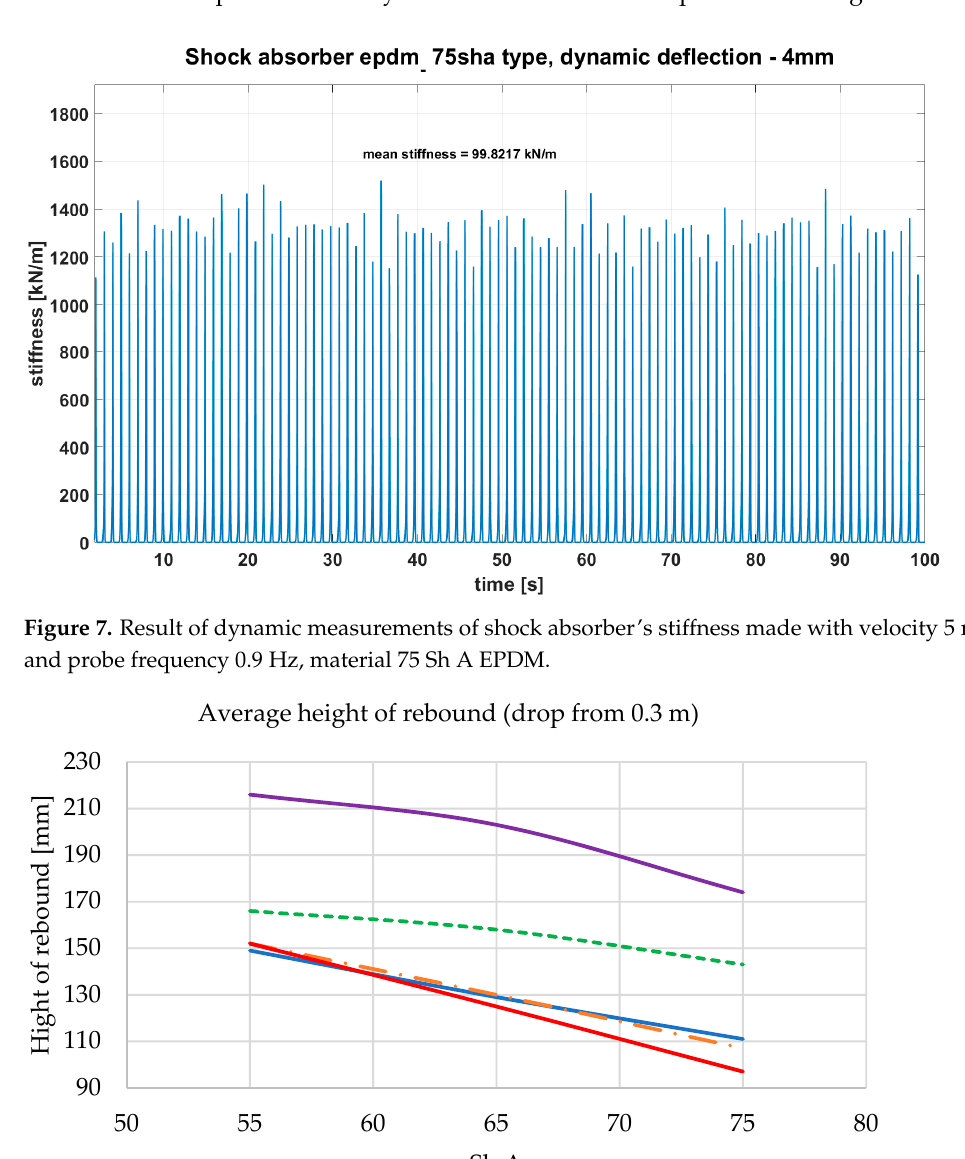
Figure 7. Result of dynamic measurements of shock absorber’s stiffness made with velocity 5 m/s and probe frequency 0.9 Hz, material 75 Sh A EPDM.